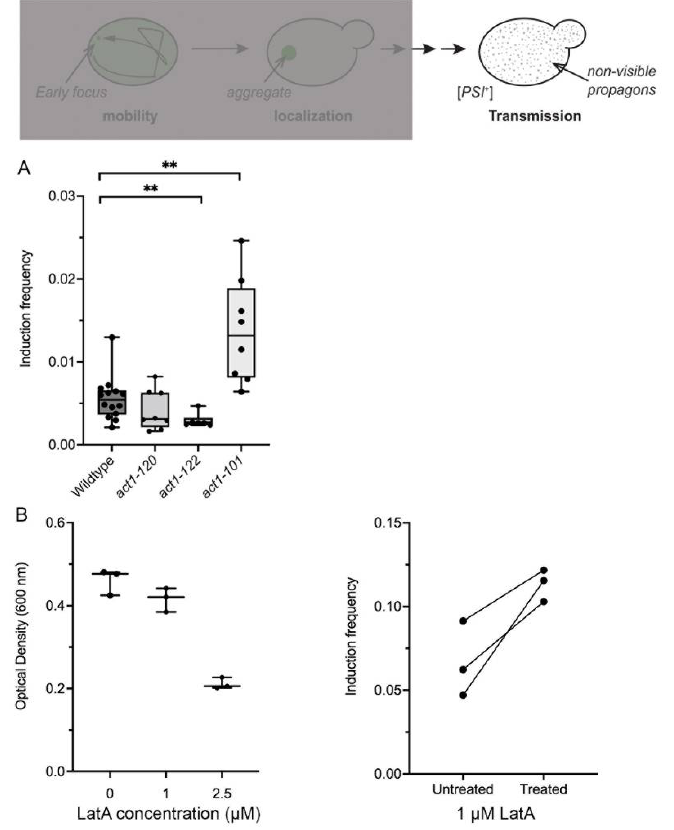
Figure 6. act1-122 strains have reduced prion induction frequency, while act1-101 and LatA-treated strains have increased induction frequency. The diagram shows that non-visible propagons (gray dots) from the original aggregate are transmitted to daughter cells to propagate [ PSI + ]. ( A ) Sup35NM-GFP was induced for 48 h in the indicated backgrounds, with cells plated on SD-Leu-Ura to score for the ability to transmit prion particles to subsequent generations. This passage is scored by prion induction frequency. Dots indicate raw values of individual trials. ** p < 0.001 by Welch’s t-test. ( B ) Left panel: 74D-694 wildtype strains were treated with the indicated concentrations of LatA and optical densities were assessed after 24 h of growth to determine whether overnight growth is inhibited. Right panel: Sup35NM-GFP was induced in paired untreated and treated cultures with 1 µ M LatA for 24 h, and then plated on rich media to determine induction frequency (see Section 2). Although each treated culture exhibits higher induction frequency relative to its untreated pair, the overall effect remains insignificant ( p = 0.055 by paired t -test). Dots indicate raw values of individual